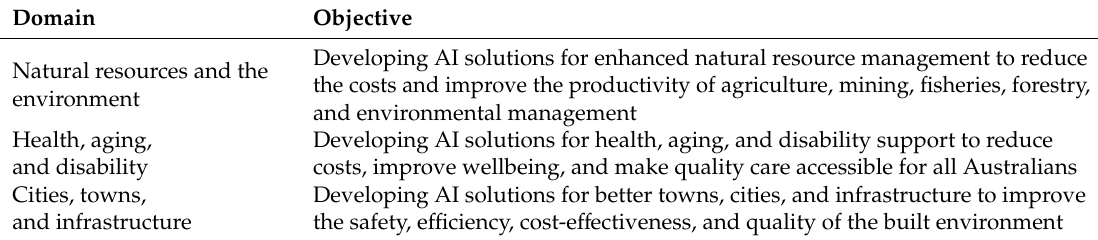
Table 3. Priority AI specialization domains and their objectives, derived from Data61